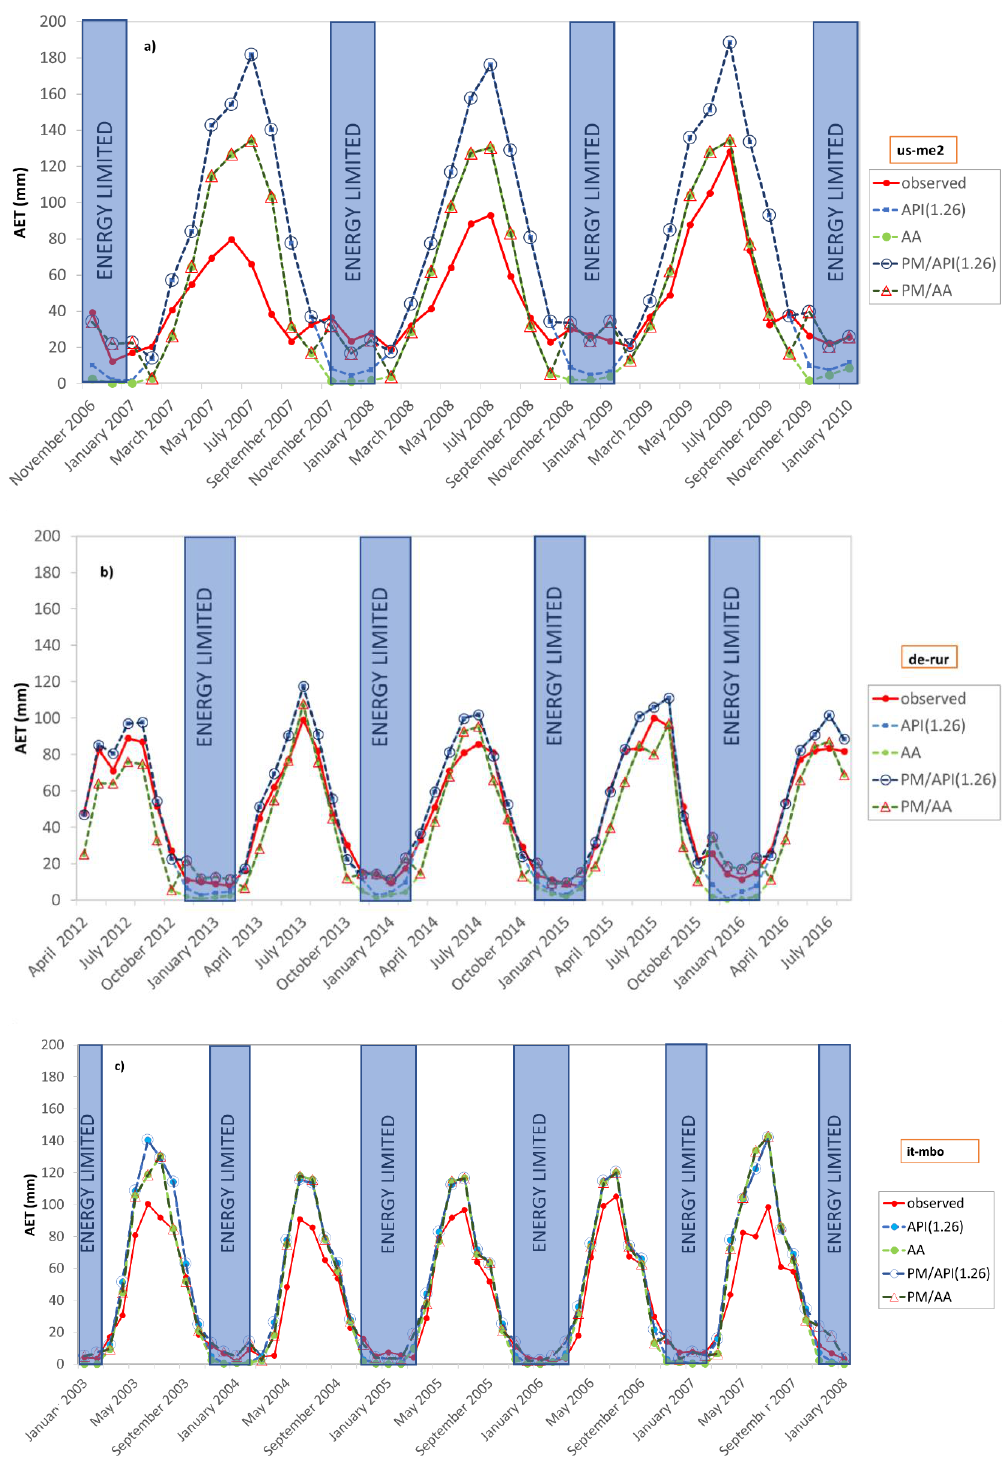
Figure 4. Monthly patterns for AET computed by the empirical and threshold approaches at the Sister site ( a ), the Rollesbroich site ( b ), and Bondone mountain ( c ). The energy limited period has been highlighted where the threshold approaches have a larger fitting. (AA = advection-aridity method; API (1.26) = API corrected potential evapotranspiration, with α = 1.26; PM/AA = Penman/advection-aridity threshold model; PM/API(1.26) = Penman/API corrected potential evapotranspiration threshold model, with α = 1.26).